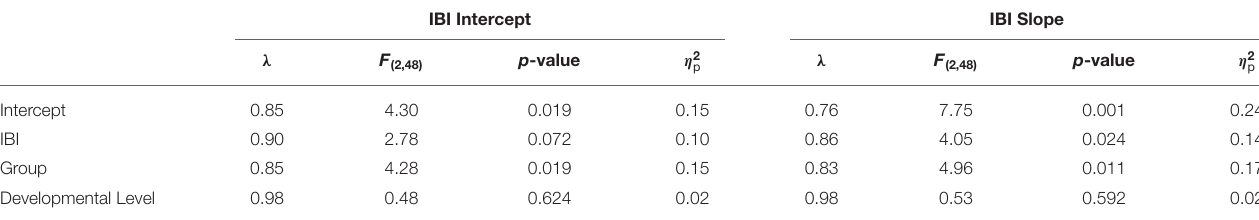
TABLE 4 | Multivariate general linear model results for IBI intercept and IBI slope at 24 months predicting later ASD and anxiety symptoms. IBI Intercept IBI